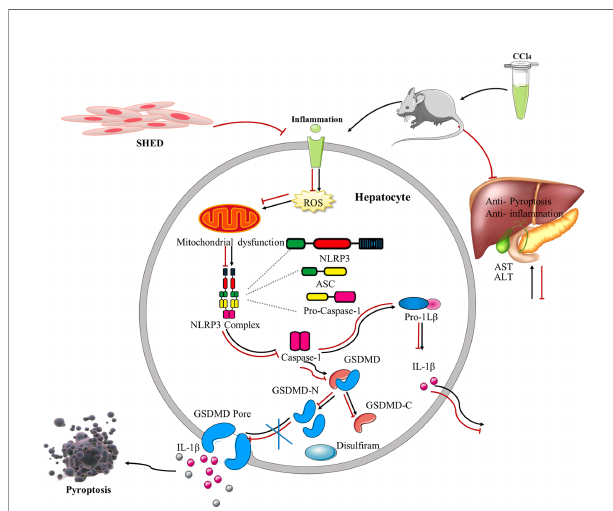
FIGURE 6 | The schematic shows SHED alleviated CCl 4 -induced liver cirrhosis via inhibiting GSDMD-mediated pyroptosis in hepatocytes. SHED, stem cells from human exfoliated deciduous teeth; GSDMD, gasdermin